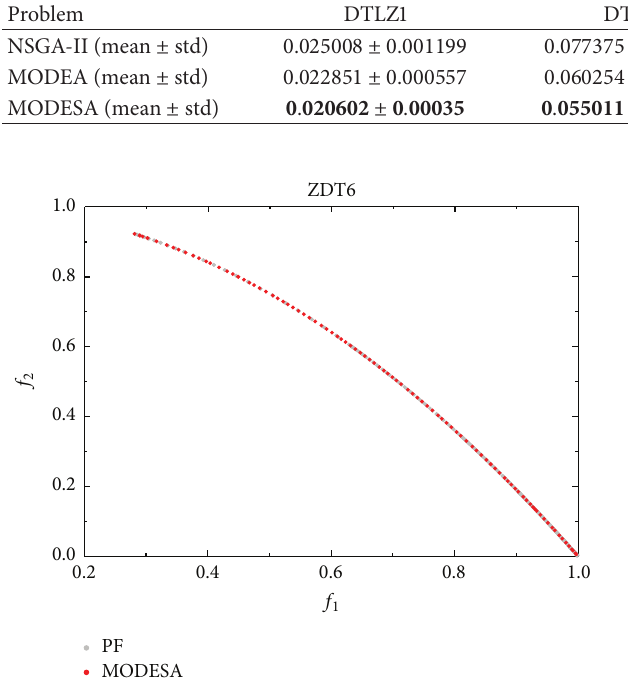
Figure 5: Plots of the nondominated solutions with the lowest IGD- metric values found by MODESA in 10 runs in the objective space on ZDT6 where 𝑁 = 100 and 𝑇 = 250 .